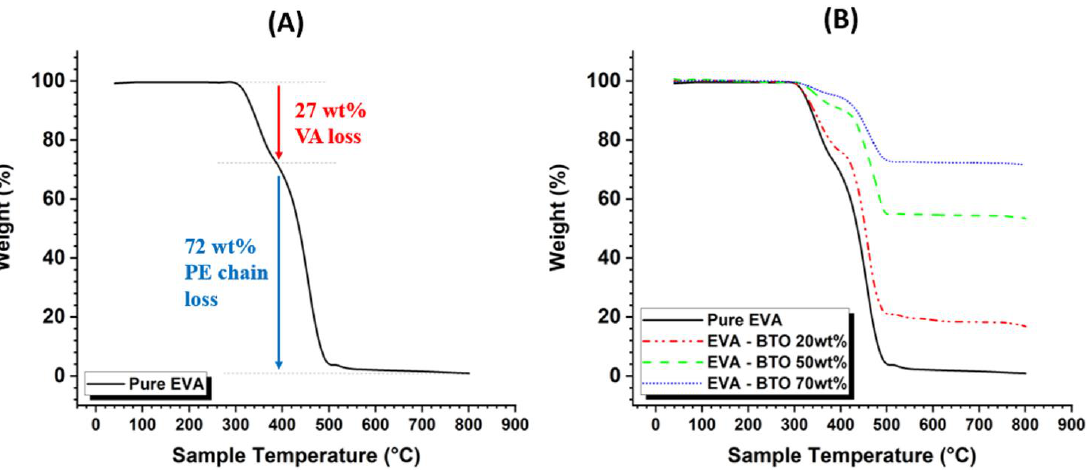
Figure 1. TGA curves of: ( A ) pure EVA, ( B ) EVA/BaTiO 3 composites at different filler